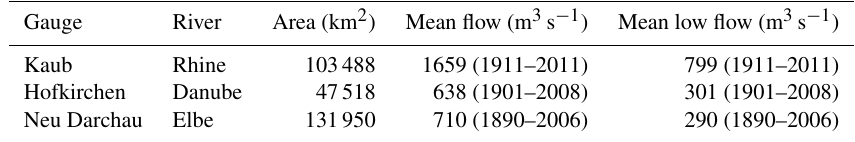
Table 1. Catchment size, annual mean and mean low flow at selected gauges for the Rhine, Danube and